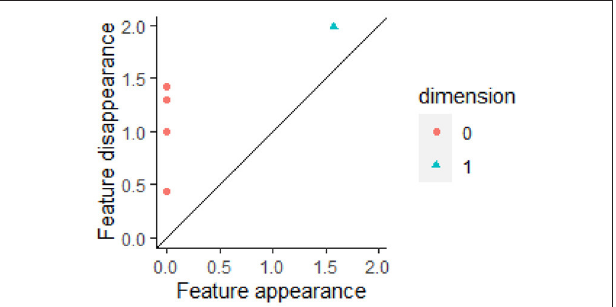
FIGURE 3 | A barcode can be converted into a persistent diagram. Each bar with finite length in a barcode is represented by a point in the persistent diagram. If a bar is born at time b and dies at time d , then the bar is represented by the point ( b , d ). In Figure 2 , there are four finite red bars plus one infinite red bar. These bars are all born at time 0. In the persistent diagram, the four finite red bars are represented by the four red points all of which have b = 0. The one blue bar in Figure 2 is represented by the blue triangle in this persistent diagram. This figure was created using the R package TDAstat ( Wadhwa et al.,